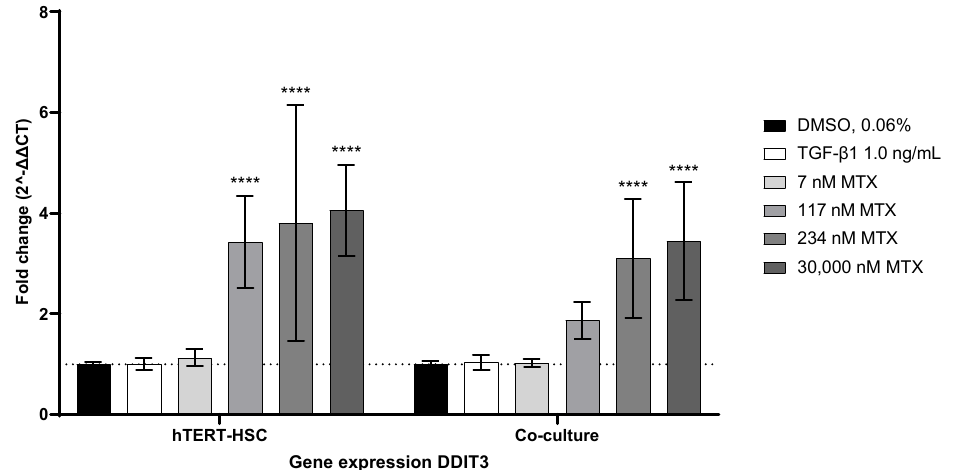
Figure 7. MTX treatment induces gene expression of ER-stress marker DDIT3 in mono- and co-cultures. hTERT-HSC monocultures or co-cultures with HepaRG were exposed to different MTX concentrations or TGF- β 1 for 7 days. Q-RT-PCR was performed to detect expression levels of DDIT3. For a better visual representation, the dashed line showing the baseline expression of DDIT3 in the solvent control, was added. Bar graphs represent means ± SD; statistical analysis based on one-way ANOVA; ****, p ≤ 0.0001; N = 3.